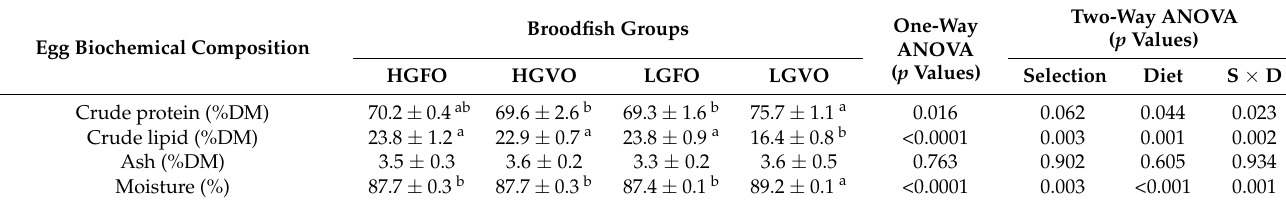
Table 13. Biochemical composition of eggs obtained from the gilthead seabream broodstock selected for high (HG) or low (LG) growth fed with either FO or VO diet over three months of reproductive season (HGFO, n = 3; HGVO, n = 3; LGFO, n = 3; LGVO, n = 3).